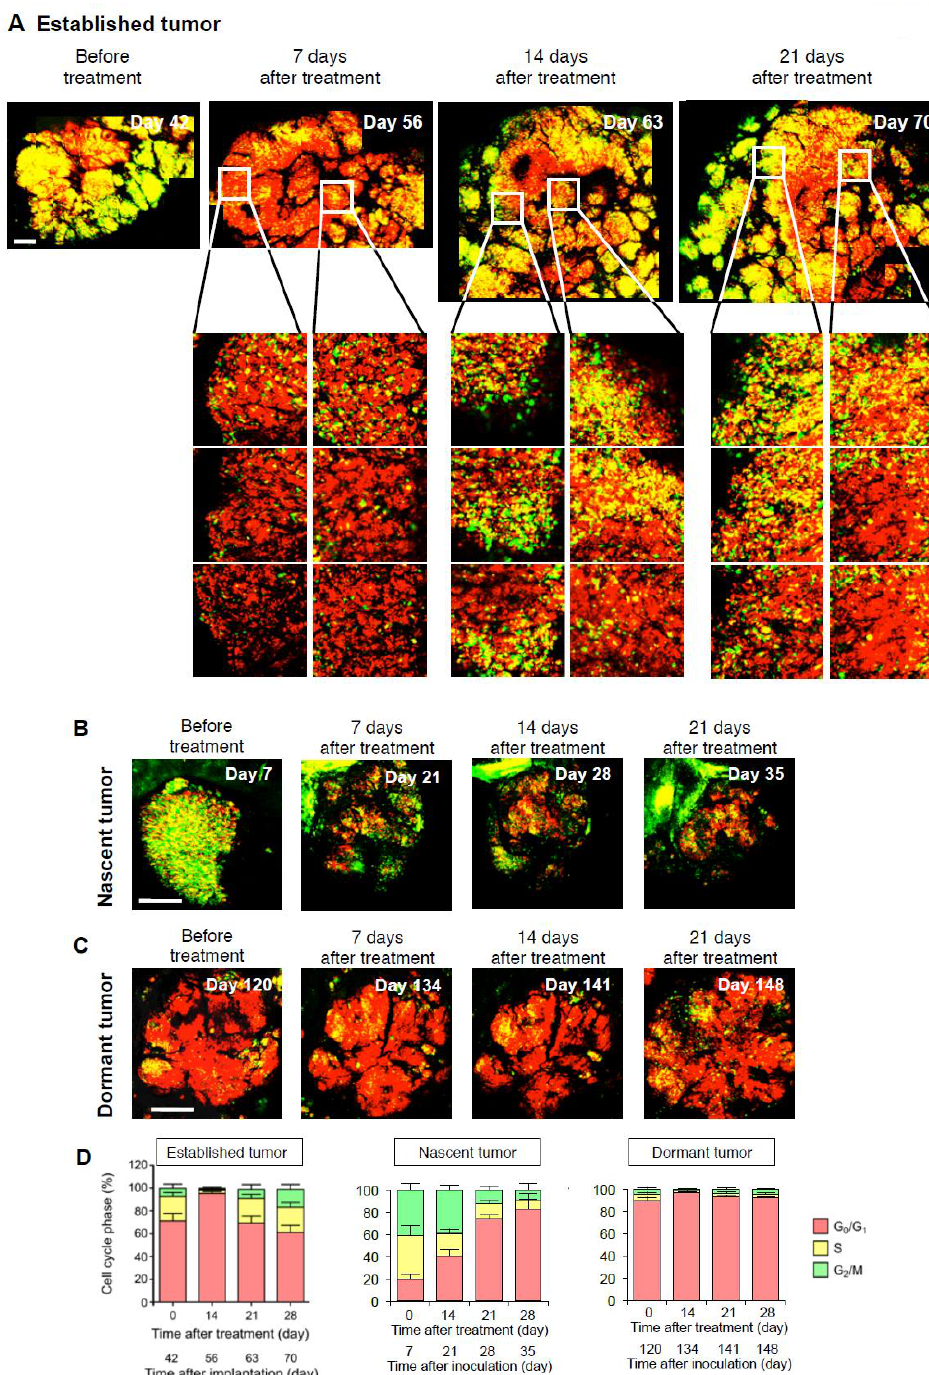
Figure 5. Response to cytotoxic chemotherapy of cells in various phases of the cell cycle within tumors. Representative images of a FUCCI-expressing tumor in the liver before and after cisplatinum (CDDP) treatment. ( A ) Representative images of an established FUCCI-expressing tumor in the liver before and after CDDP treatment. ( B ) Representative images of a nascent FUCCI-expressing tumor in the liver before and after CDDP treatment. ( C ) Representative images of a dormant FUCCI-expressing tumor in the liver before and after CDDP treatment. ( D ) Histogram shows the cell cycle phase distribution of cancer cells in the tumor at the indicated time points. Data are means ± SD (each group for n = 5). Scale bars represent 500 μm. (Reproduced from [46] with the permission of Taylor and Francis).